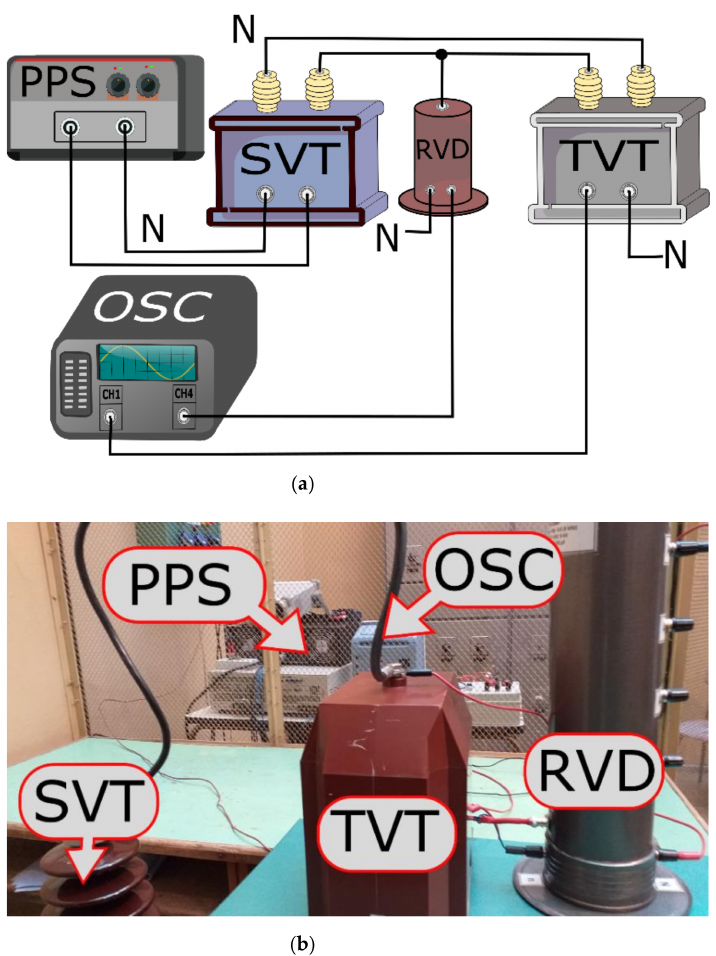
Figure 3. The measuring system used for evaluation of the transformation accuracy of slow-front transient overvoltages: ( a ) block diagram, and ( b ) photo of the test